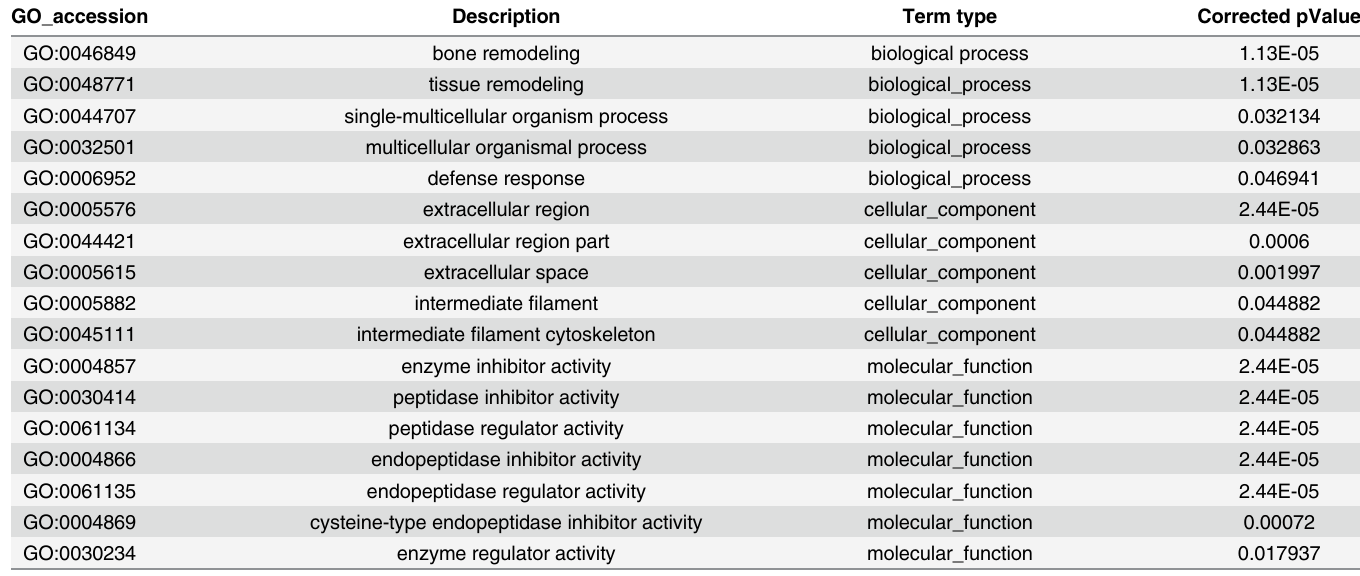
Table 4. Gene ontology analysis of differentially expressed genes in sheep skin between Stage 0 and Stage 1of secondary HF morphogenesis. GO_accession Description Term type Corrected